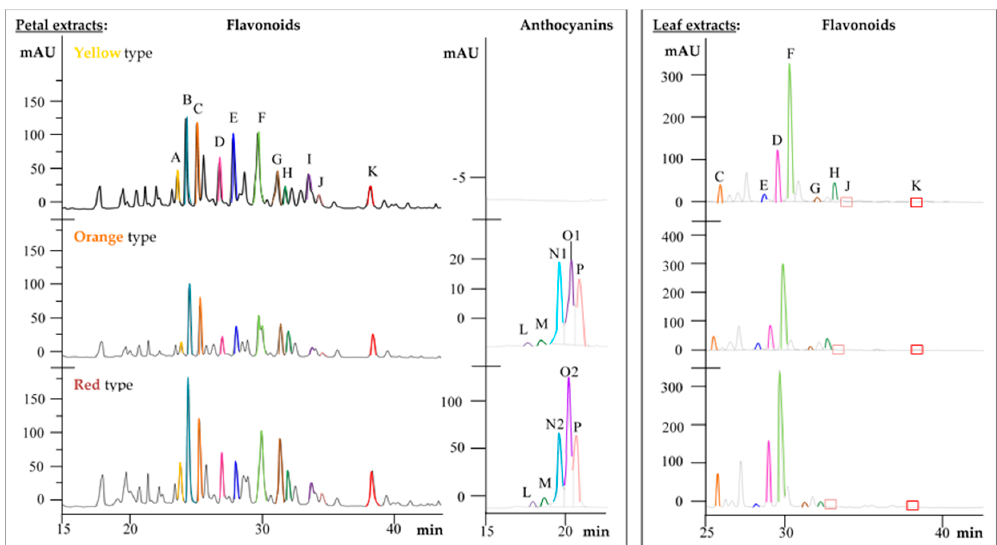
Figure 2. Comparison of high performance liquid chromatograms of Primula veris L. petal and leaf extracts covering flavonoid glycosides at 280 nm and anthocyanins at 520 nm. Identical compounds are marked with the same color and the letters A to P: A: (+)-Catechin (yellow); B: Methyl-myricetin-trihexoside (light blue); C: Quercetin-trihexoside (orange); D: Kaempferol-3- O -diglucoside-7- O -glucoside (pink); E: Quercetin-3- O -gentiobioside (blue); F: Kaempferol-3- O -galactoside-rhamnoside-7- O -rhamnoside (light green); G: Quercetin-methylether-rhamnoside-glucoside-rhamnoside (brown); H: Quercetin-3- O -rutinoside (grey); I: Methyl-quercetin-dihexoside (purple); J: Kaempferol-3- O -rutinoside (light red); K: Methyl-quercetin-rhamnoside-hexoside (red); L: Cyanidin-hexoside (light purple); M: Cyanidin-glucoside (dark green); N1: Coelution of peonidin-dihexoside and peonidin-hexoside (aqua); N2: Coelution of peonidin-hexoside and malvidin-hexoside (aqua); O1: Coelution of malvidin-hexoside and peonidin-hexoside (purple); O2: Peonidin-dihexoside (purple); P: Malvidin-hexoside